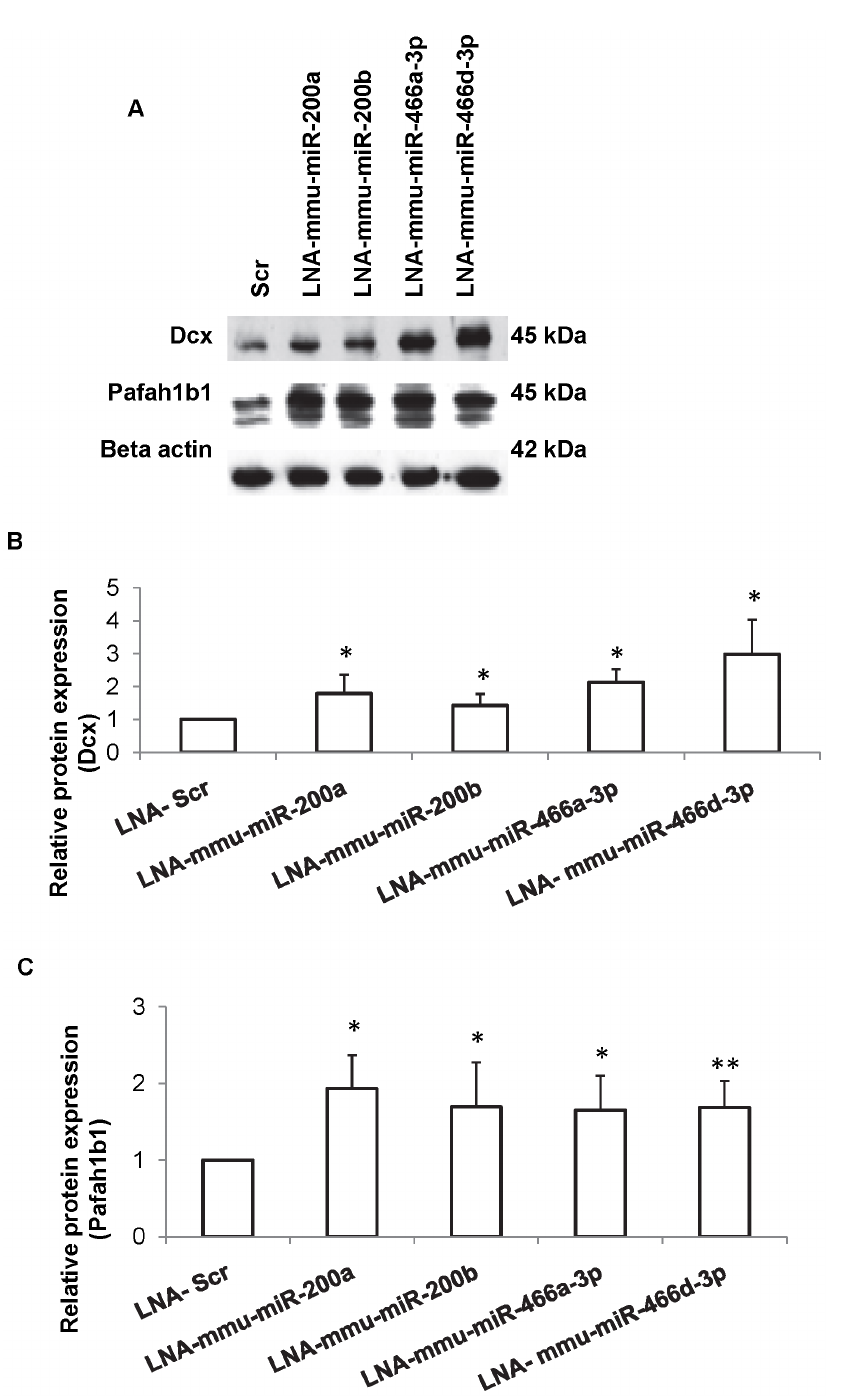
Figure 4. miRNA loss of function confirms Dcx and Pafah1b1 as targets. (A) Representative Western blot showing Dcx and Pafah1b1 protein expression after knockdown of specific miRNAs in NSCs. (B,C) The quantities of Dcx (B) and Pafah1b1 (C) proteins increased significantly in NSCs following knockdown of mmu-miR-200a or mmu-miR-200b or mmu-miR-466a-3p or mmu-miR-466d-3p when compared to scrambled (scr) transfected cells. Data is represented as mean 6 SD from at least four independent experiments, *p , 0.05. * *p ,